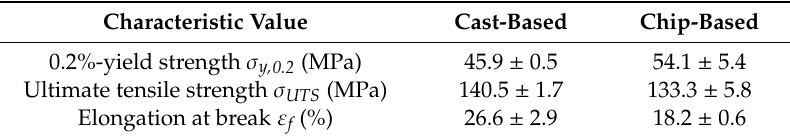
Table 3. Material characteristics obtained from tensile